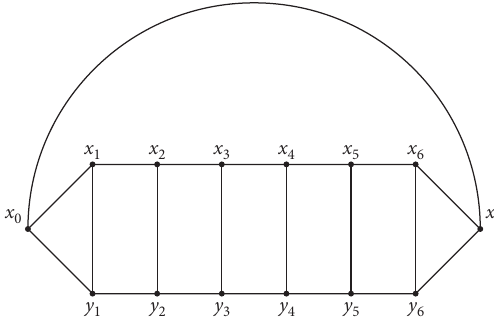
Figure 1: Subdivision of necklace graph S ( N